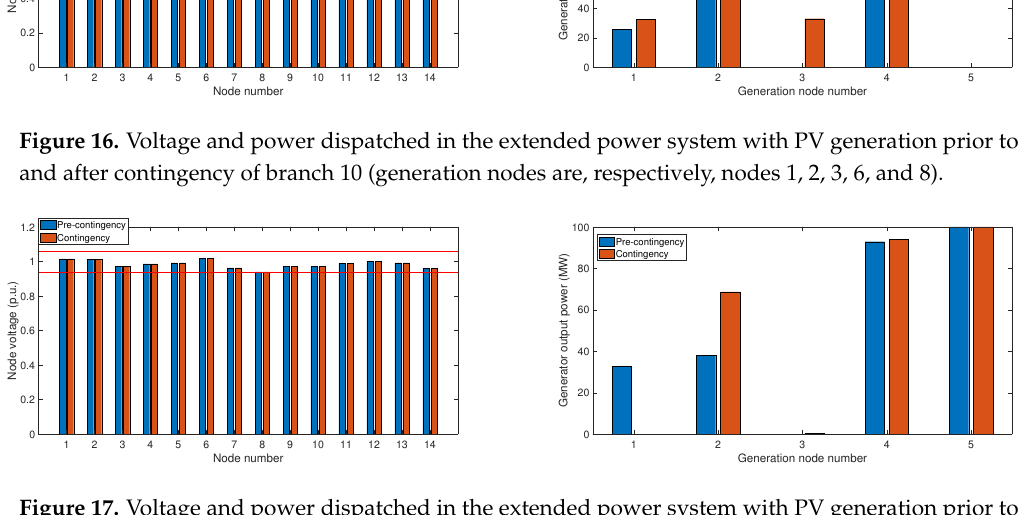
Figure 17. Voltage and power dispatched in the extended power system with PV generation prior to and after contingency of branch 16 (generation nodes are, respectively, nodes 1, 2, 3, 6, and 8).